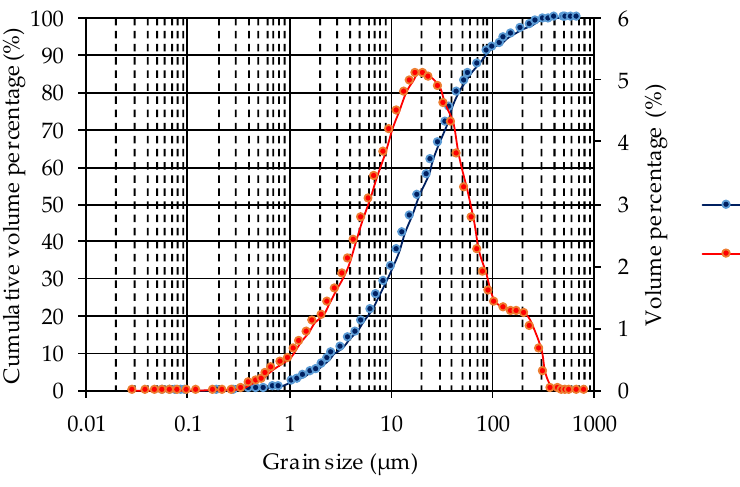
Figure 1. Average grain size distribution curves for Mine A tailings.